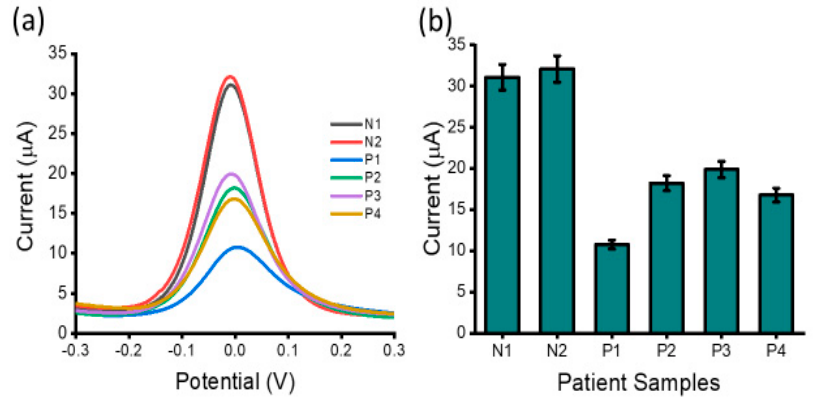
Figure 7. Detection of lncRNA in patient samples: ( a ) readout displaying current output for ovarian carcinoma negative patient samples (N1 and N2) and ovarian carcinoma positive patient samples (P1, P2, P3 and P4) and ( b ) carcinoma positive samples in comparison to carcinoma negative patient samples. Error bars represent the standard deviation across three separate experiments.